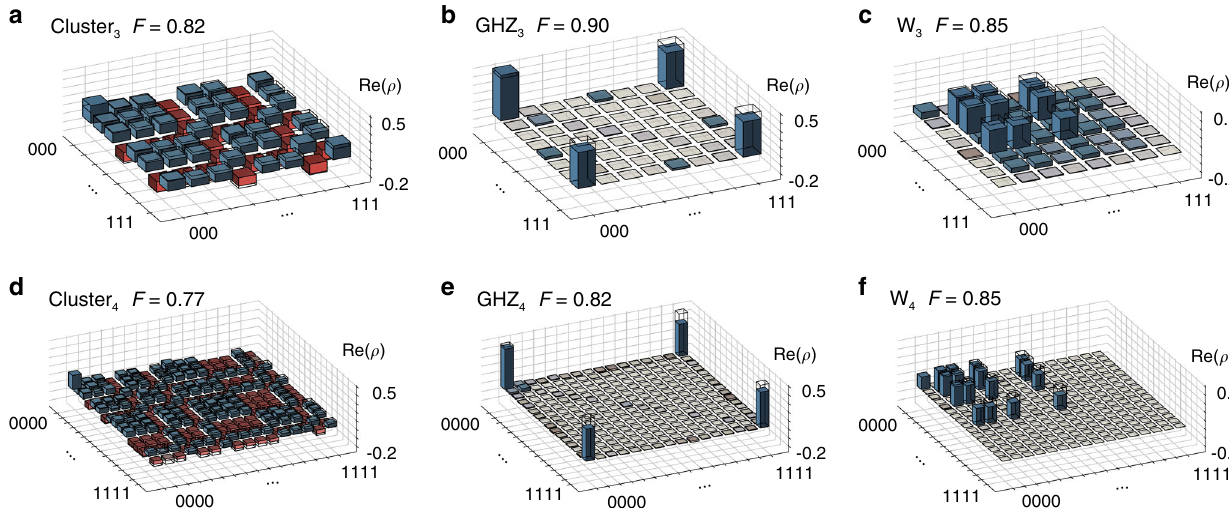
Fig. 3 Complete state tomography. a – c Three- and d – f four-mode state tomography. We plot the real part Re ð ρ Þ of the most likely density matrices ρ (bars) for a , d the cluster state, b , e the GHZ state, and c , f the W state. Absolute values of the imaginary part (not shown) are all below 0.03. Ideal density matrices ρ ideal are shown as black wireframes. The fi delity F ¼ Tr (0)000 to (1)111.